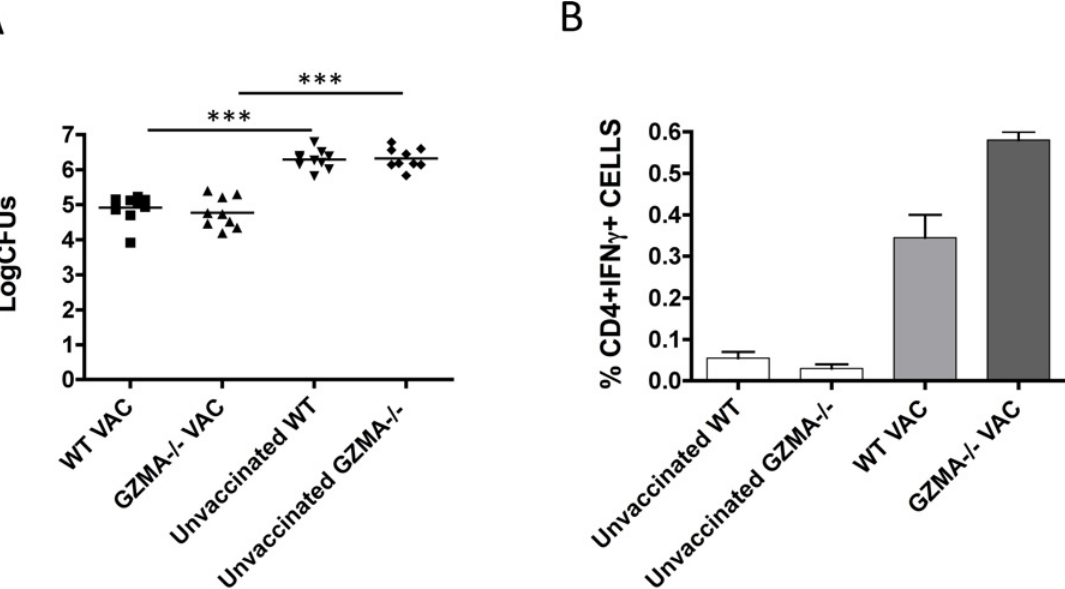
Fig 3. GZMA-/- mice are not less protected by MTBVAC vaccination. Groups of nine C57BL/6 WT or GZMA-/- mice were vaccinated subcutaneously with 10 6 CFU of MTBVAC (WT VAC or GZMA-/- VAC), or non-vaccinated. A , at two months post-vaccination, mice were inoculated intranasally with a low-dose challenge of H37Rv, and four weeks later lung bacterial burden was determined. Data from one experiment are represented in the graph. One-way ANOVA test with Bonferroni post analysis was performed to calculate statistical significance. * p < 0.05; ** p < 0.01; *** p < 0.001. B , cells were stimulated with PPD as described in materials and methods section, and CD4+IFN γ + cells frequency in lungs was determined by flow cytometry. Data from one experiment are represented in the graph as mean ±